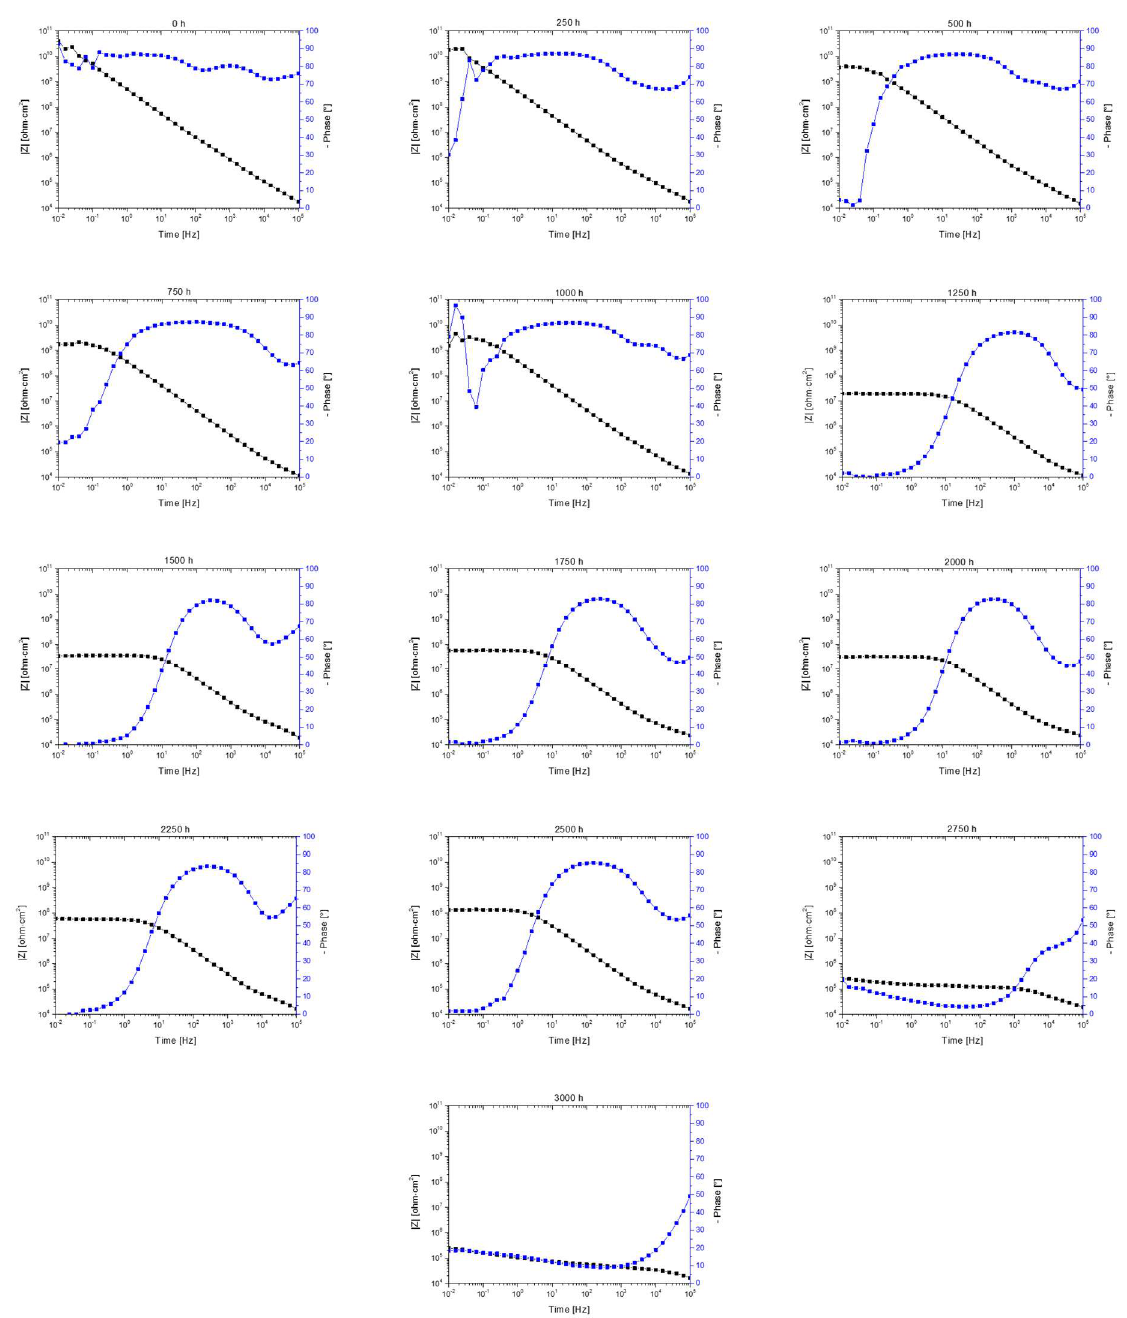
Figure A2. EIS spectra of a painted HDG steel sample at different aging times during the prohesion test.